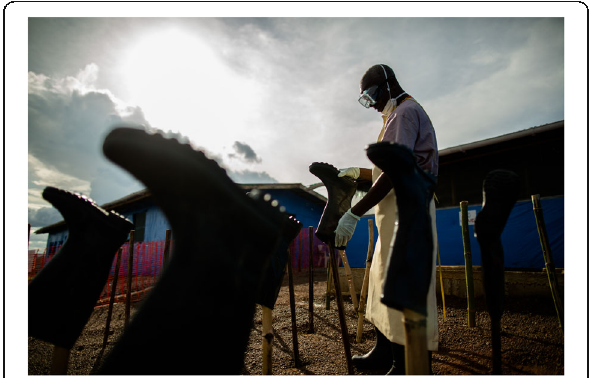
Fig. 1 Suakoko, Bong County, Liberia, October 7, 2014: health care worker disinfecting boots at the Bong County Ebola treatment unit. Photo by Morgana Wingard,